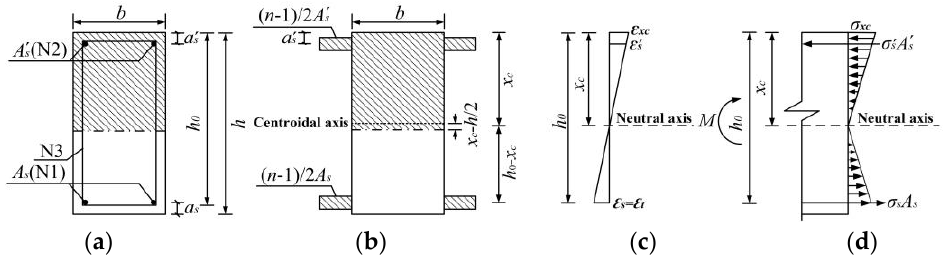
Figure 15. Stress and strain diagrams of the pile normal section in stage I. ( a ) Pile section; ( b ) transformed section; ( c ) distribution of average strain; ( d ) distribution of normal stress.